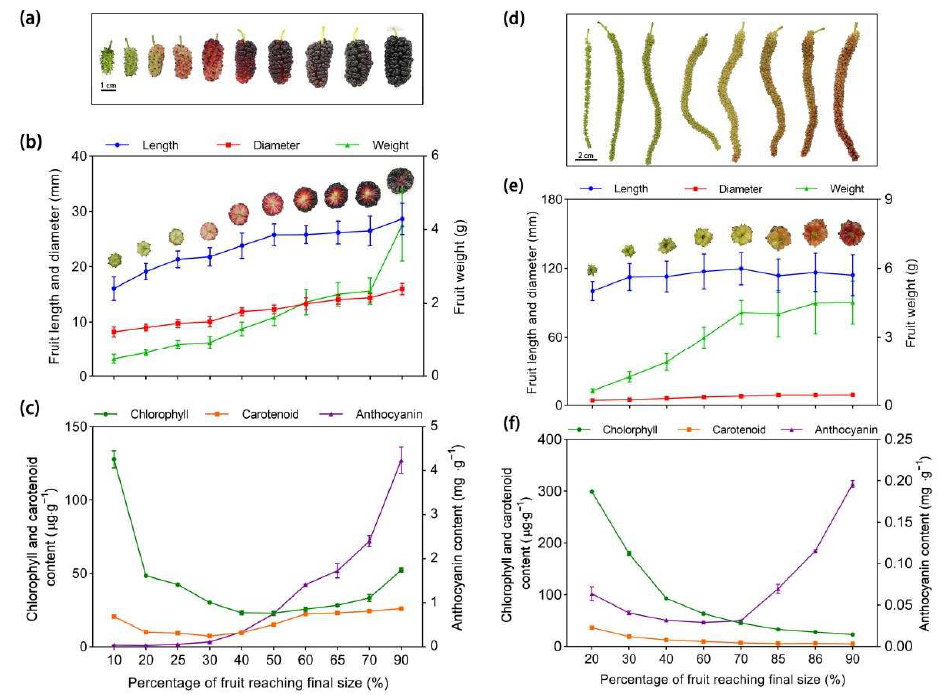
Figure 8. Fruit photographs, size and pigment content in ‘ZJ’ and ‘XF-CSS’ mulberries at different developmental stages (stages 7 and 8) (data gathered in 2022). ( a – c ) Fruit photographs, size and pigment content in ‘ZJ’; ( d – f ) fruit photographs, size and pigment content in ‘XF-CSS’.